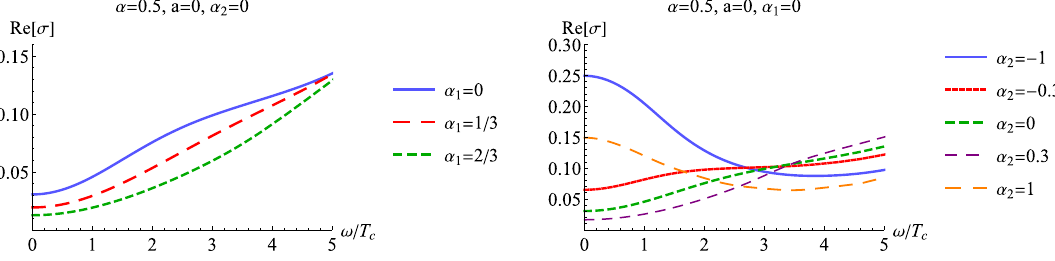
Fig. 8 The real part of conductivity as the function of the frequency at T / T c ≈ 0 . 2. Left plot: different α 1 for α = 0 . 5, a = 0 and α 2 = 0. Right plot: different α 2 for α = 0 . 5, a = 0 and α 1 = 0. Here we have abbreviated the two dimensionless quantities { T /μ,α/μ } to { T ,α }